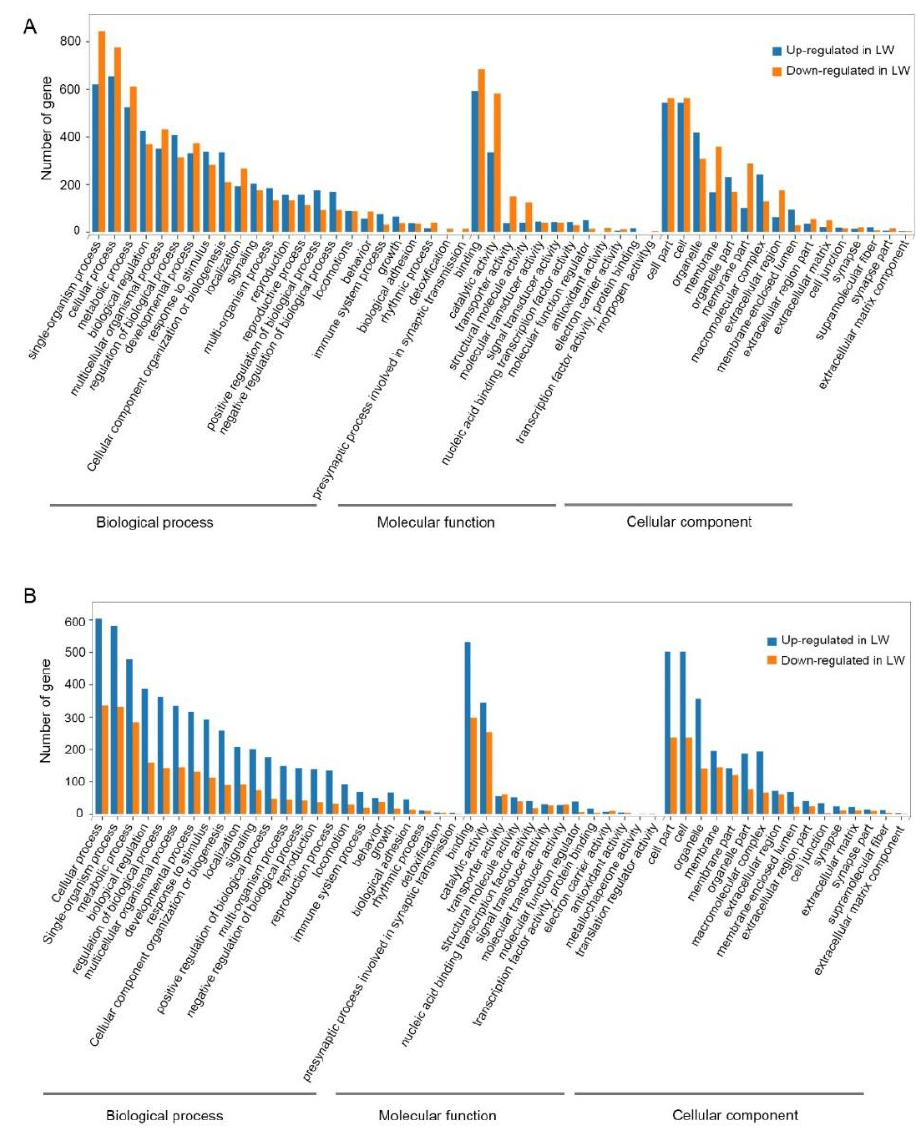
Figure 8. GO classification of DEGs in forewing ( A ) and hindwing ( B ) buds of 48 hAE-5th-instar nymphs with NlFoxO and Gfp knockdown. GO was summarized as three main categories (CC, MF and BP).